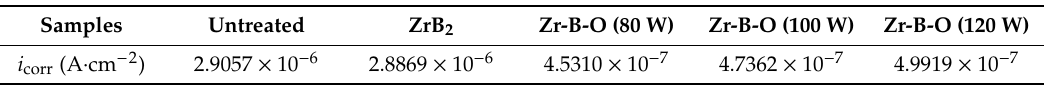
Figure 9. Potentiodynamic polarization curves of the stainless-steel substrate, ZrB 2 monolayer and Zr-B-O nanocomposite films.